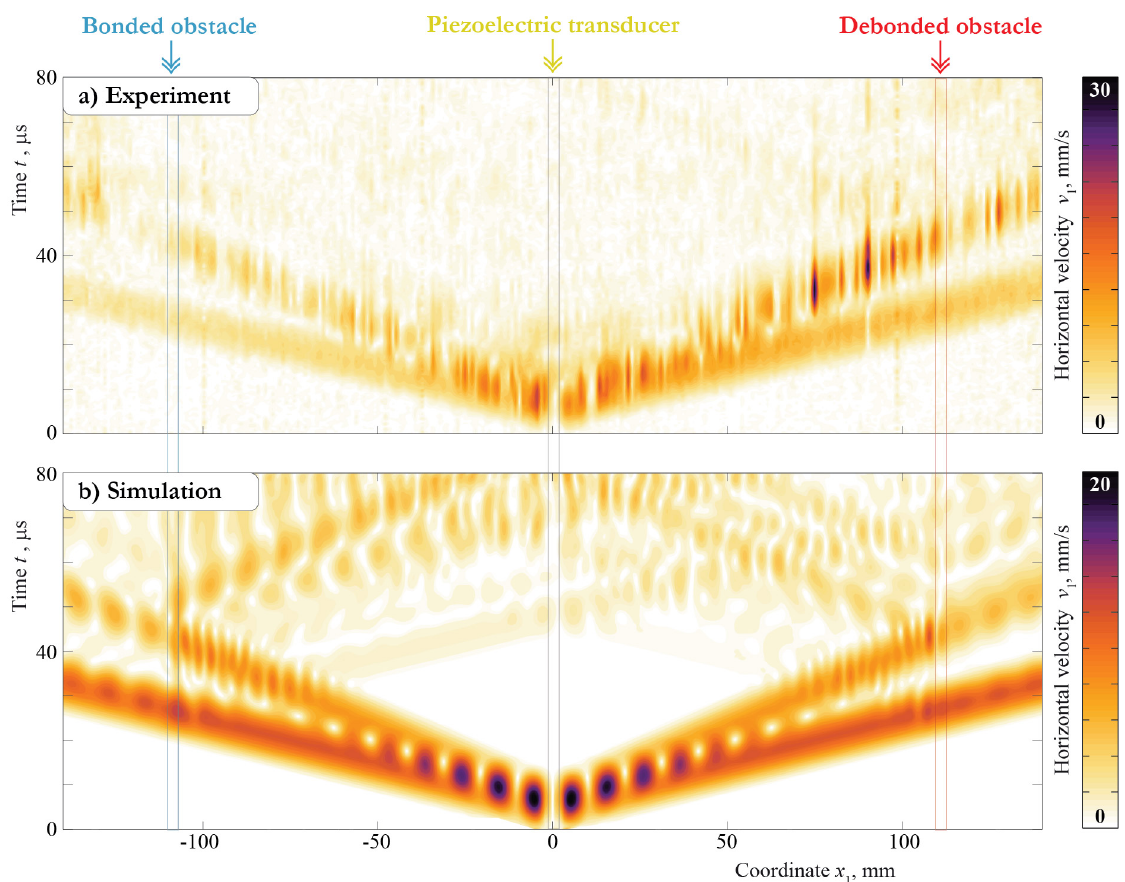
Figure 8. Horizontal velocities at the surface of the plate for bonded ( a ) and debonded ( b ) obstacles measured and calculated with the central frequency f = 300